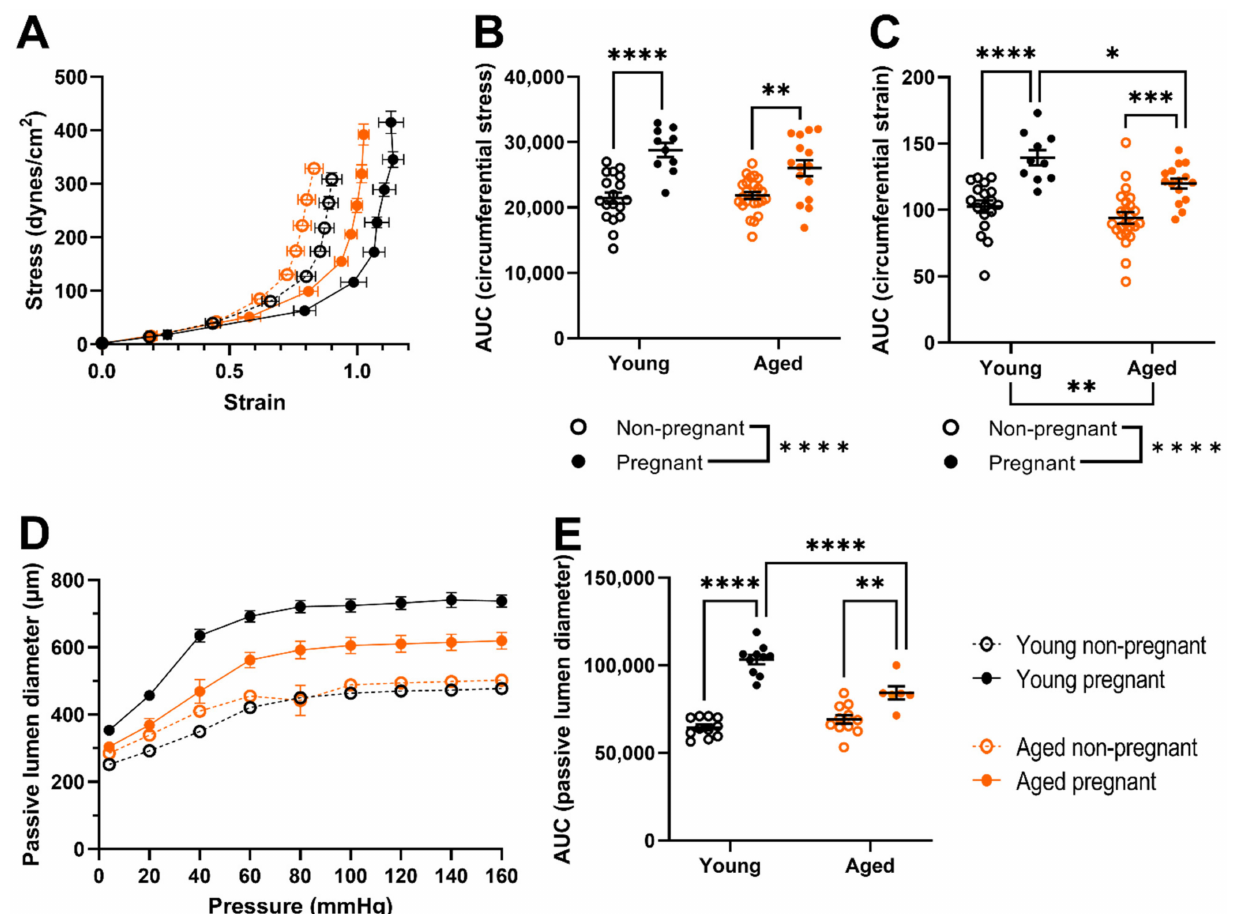
Figure 3. Passive (mechanical) pressure myography outcomes for main uterine arteries from young (black) and aged (orange) nonpregnant (open circles) and pregnant (GD 20; closed circles) rats. ( A ) Circumferential stress-strain; ( B ) Stress area under the curve (AUC); ( C ) Strain AUC; ( D ) Pas- sive lumen diameter; ( E ) Passive lumen diameter AUC of arteries. All outcomes were assessed under calcium-free conditions to prevent smooth muscle cell contraction. Data presented as mean ± SEM; n = 10–24 rats/group. Outcomes were compared as AUC using a two-way ANOVA (age vs. pregnancy status) followed by Sidak’s post hoc test. * p < 0.05; ** p < 0.01; *** p < 0.001; **** p <